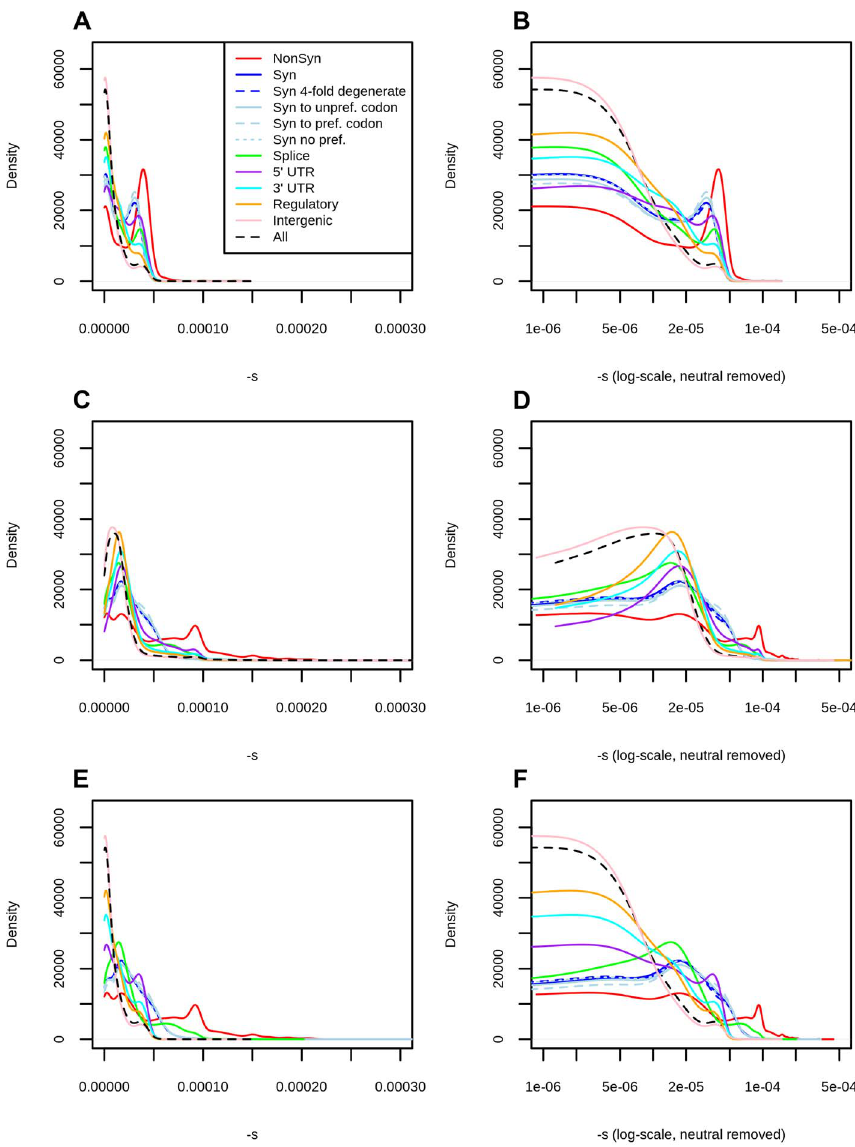
Figure 2. Distribution of fitness effects among YRI polymorphisms in the Complete Genomics dataset, partitioned by the genomic consequence of the mutated site. The right panels show a zoomed-in version of the distributions in the left panels, after removing neutral polymorphisms and log-scaling the x-axis. A) DFE obtained from the genome-wide mapping. B) Zoomed-in version of panel A. C) DFE obtained from the exome-wide mapping. D) Zoomed-in version of panel C. E) DFEs for exonic sites (nonsynonymous, synonymous, splice sites) obtained from the exome-wide mapping and DFEs for non-exonic sites (intergenic, UTR, regulatory) obtained from the genome-wide mapping. F) Zoomed-in version of panel E. Consequences were determined using the Ensembl Variant Effect Predictor (v.2.5). Codon and degeneracy information was obtained from snpEff. If more than one consequence existed for a given SNP, that SNP was assigned to the most severe of the predicted categories, following the VEP’s hierarchy of consequences. NonSyn = nonsynonymous. Syn = synonymous. Syn to unpref. codon = synonymous change from a preferred to an unpreferred codon. Syn to pref. codon = synonymous change from an unpreferred to a preferred codon. Syn no pref. = synonymous change from an unpreferred codon to a codon that is also unpreferred. Splice = splice